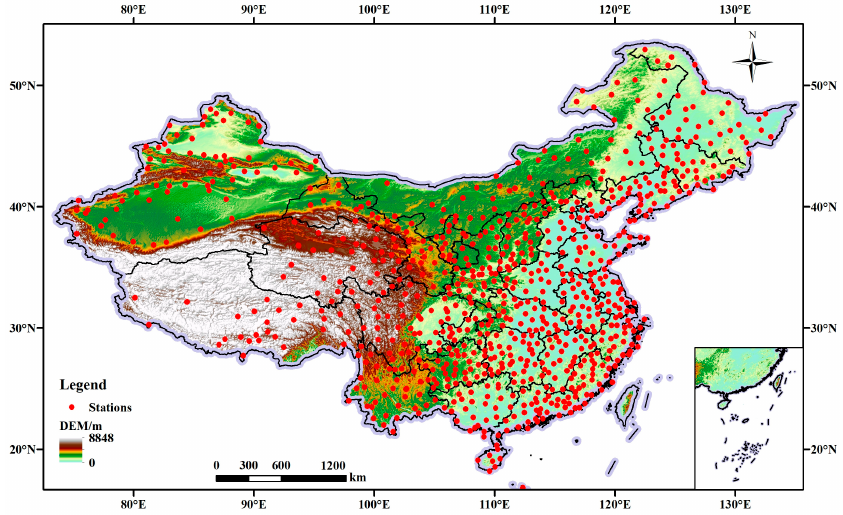
Figure 1. Location map of meteorological stations and the rough elevation.